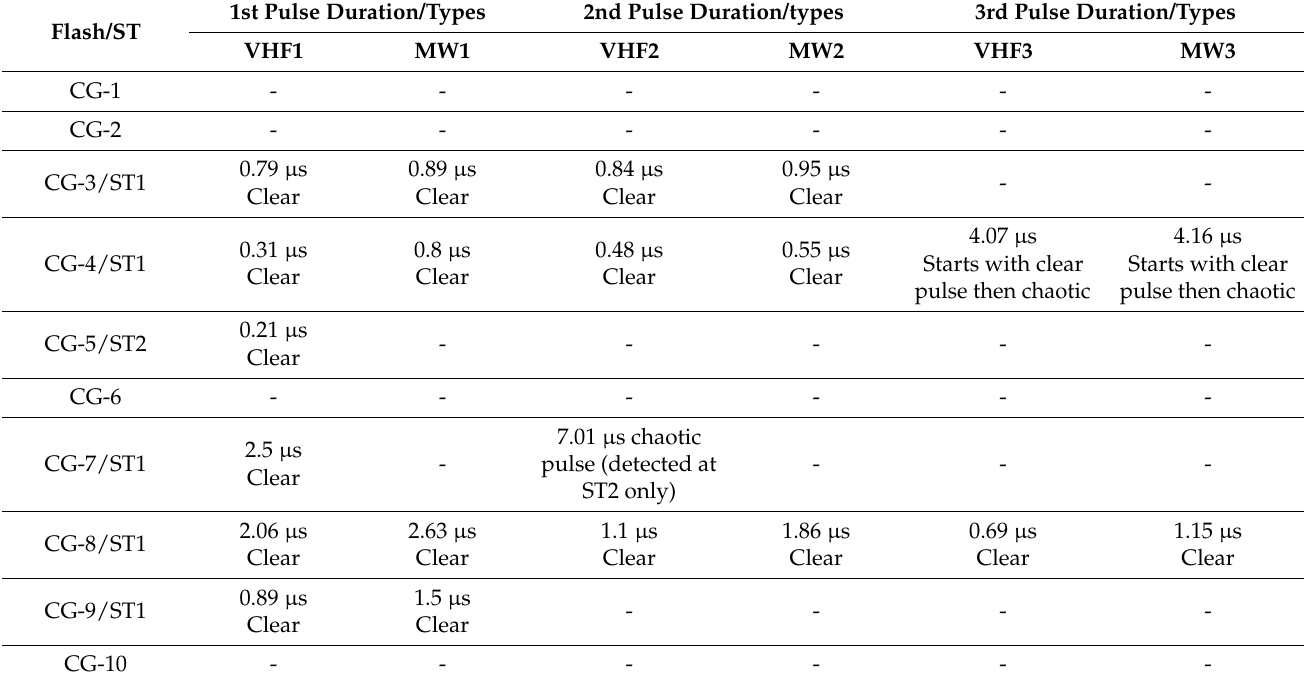
Table 1. Microwave and VHF radiation pulses detected before the onset of